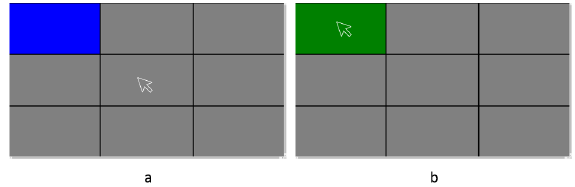
Figure 3. (a) Task screen with blue stimuli (b) When user makes selection, the blue block turns green.